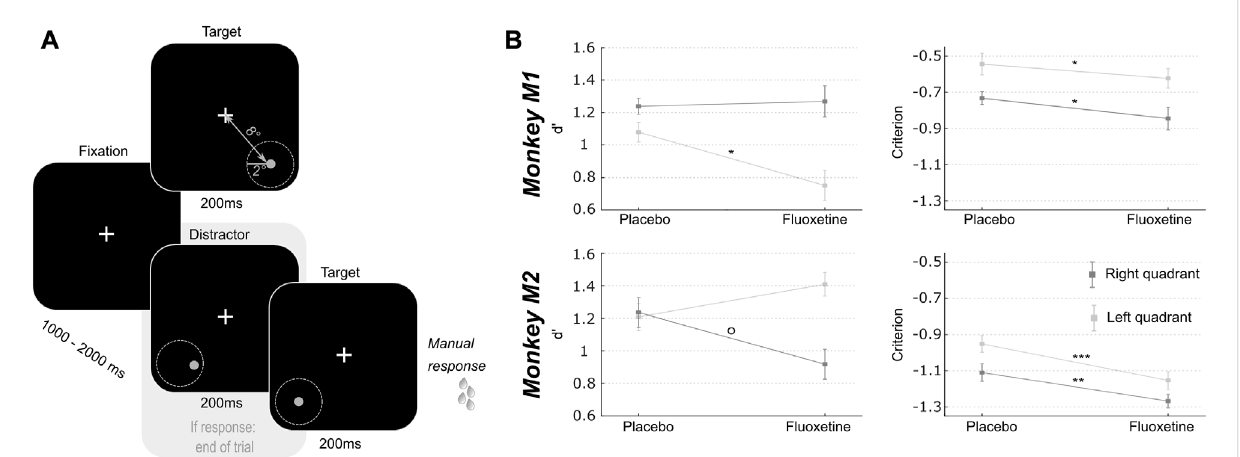
FIGURE 2 Effect of fl uoxetine on spatial sensitivity d-prime and response criterion in a target detection task in the presence of spatial distractors. (A) Monkeys hadtodetectatargetpresentedinoneoftwoquadrants(lowerleftorlowerright).Targetluminositywaskepthighandpresentedata fi xedlocation,at8 ° of eccentricity from the center of the screen, for 200 ms. Monkeys were rewarded for a speeded detection of target presentation. On 75% of the trials, targets werepreceded by adistractor, undistinguishable from the target exceptfor its spatial location. These distractorswere located within acircle of 2 ° of eccentricity around the target. Responses to these distractors interrupted the trial and monkeys were not rewarded. (B) For both monkeys, d ’ and criterion were computed independently for each target (left, light gray; right, dark gray). Median+/-median absolute error are presented for placebo and fl uoxetine conditions. Statistical signi fi cance is represented as follows: ***, p < 0.001; **, p < 0.01; *, p < 0.05; ° , p < 0.07. See also companion Supplementary Table S3 for detailed